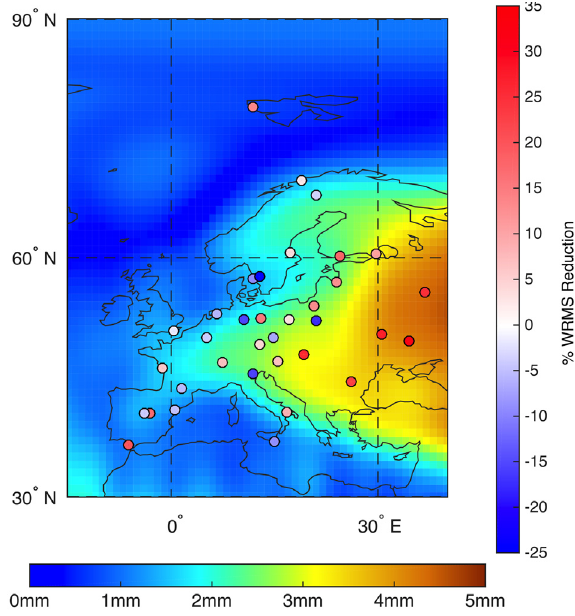
Figure 5. WRMS reductions when GRACE signals have been re- moved from GPS heights. Colors of the circles and scales on right represent the percentages of WRMS reduction. Background color map and scale (at the bottom) are the same as in Figure